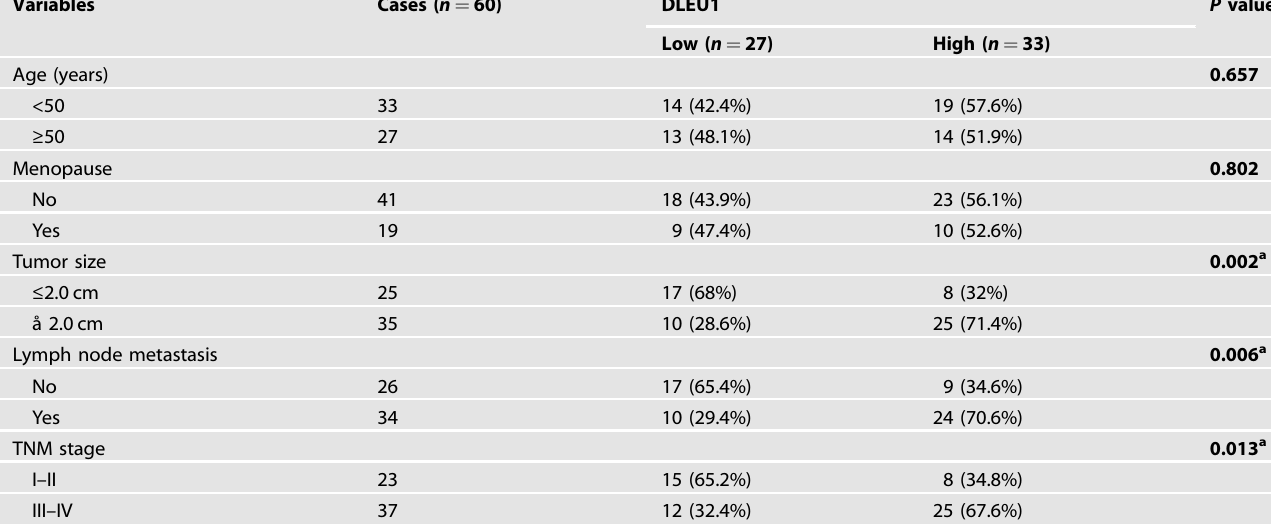
Table 1. Association between DLEU1 and clinicopathological characteristics of breast cancer patients.